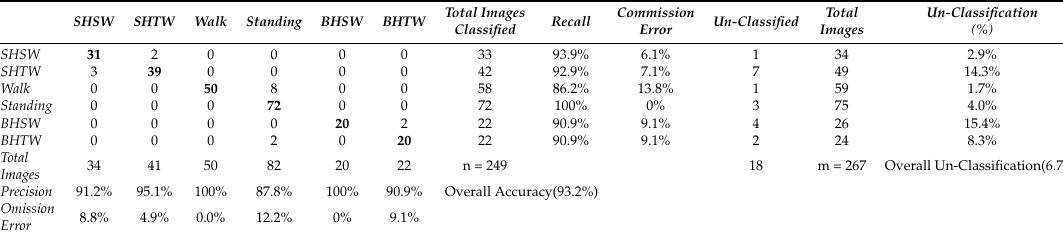
Table 4. Classification matrix for Ira